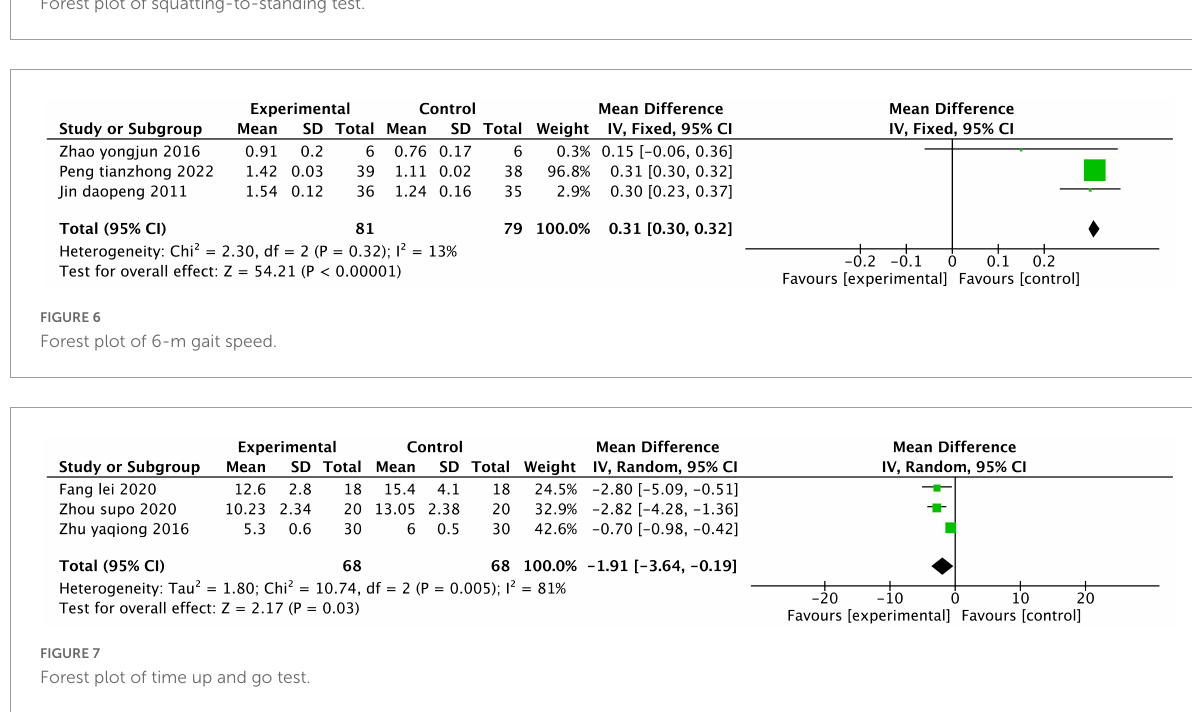
FIGURE5 Forest plot of squatting-to-standing test.